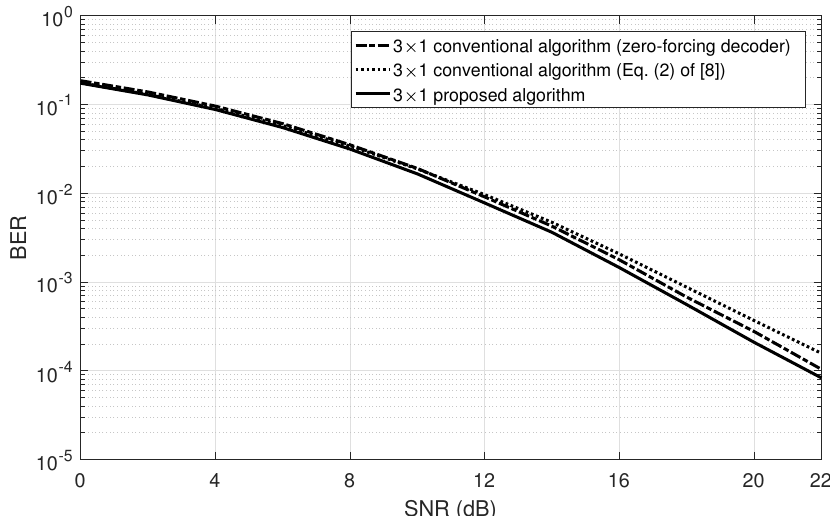
Figure 5. BER performance of the conventional QO-STBC and proposed algorithm as a function of the SNR for the three antennas system in a correlated Rayleigh fading channel (the correlation coefficient =